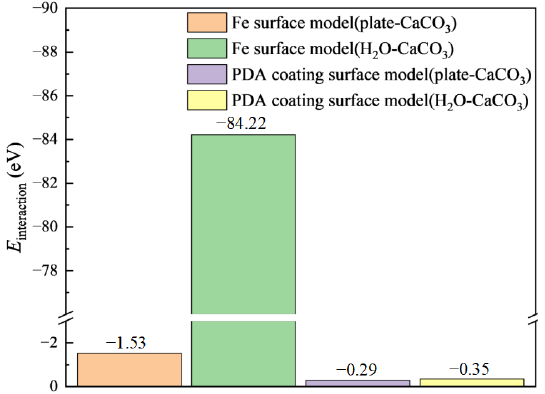
Figure 10. Comparison of interaction